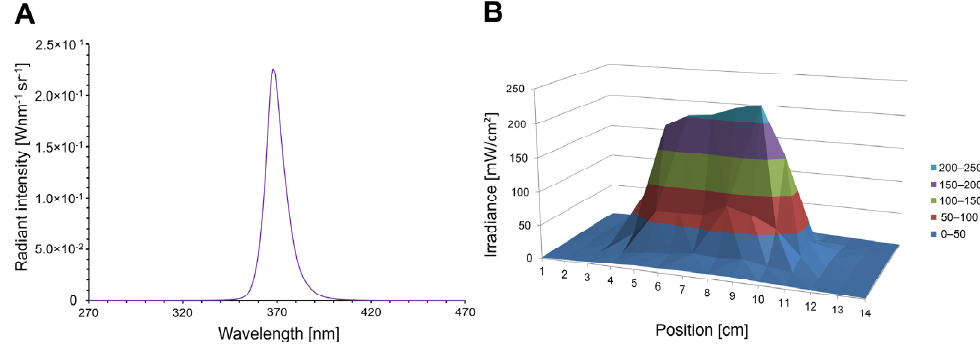
Figure 2. ( A ) Mean emission spectrum of the applied ultraviolet A (UVA)-LED. ( B ) Irradiance in the target range.